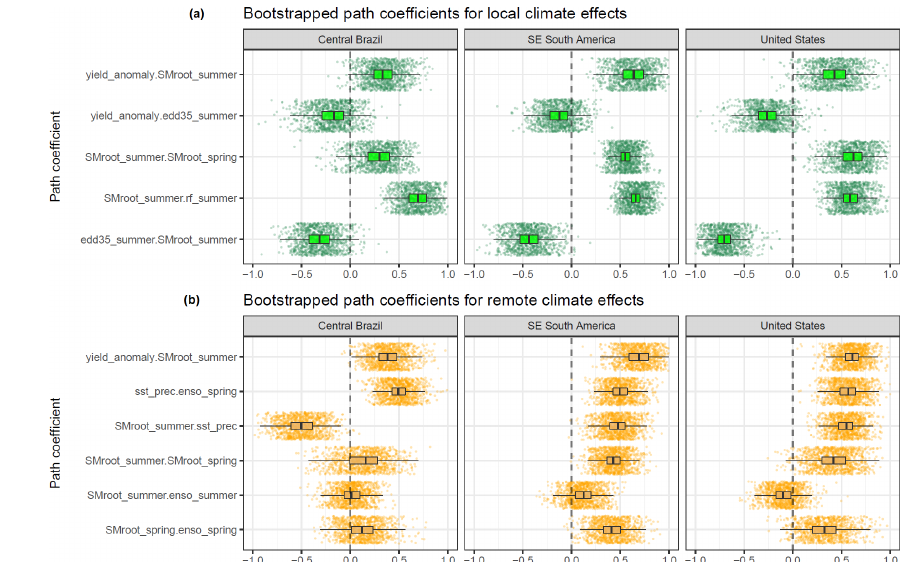
Figure A1. (a) Bootstrapped path coefficient estimates based on 1000 draws for local climate effect models. (b) Bootstrapped path coefficient estimates based on 1000 draws for remote climate effect models. The path coefficient names are listed as X1.X2 and represent the direct effect of X2 on X1. “edd35” stands for extreme heat, “rf” stands for rainfall, “sst_prec” stands for the NP–SA pattern, and “SMroot” stands for for soil moisture.